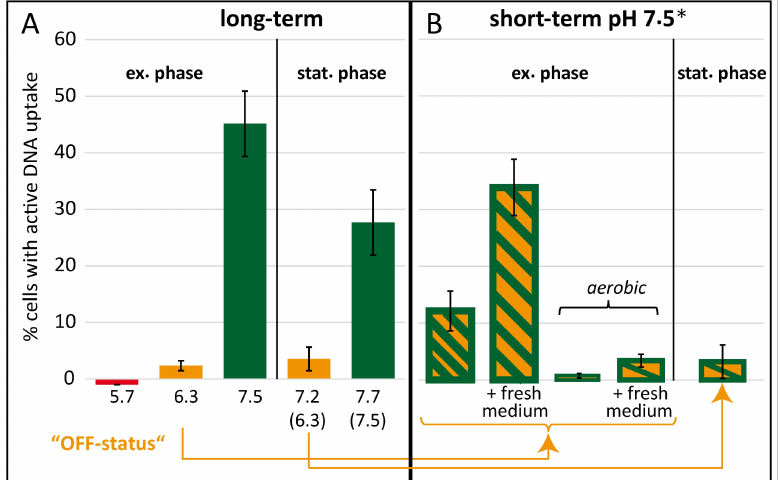
Figure 4. pH and atmosphere determine competence development in C. jejuni . Experimental setups for “long-term pH” ( A ) and “short-term pH shift” ( B ) of C. jejuni BfR-CA-14430 were as described in Figure 3. Final pH values ± 0.2 of cultures tested in the DNA uptake assay were as indicated, with initial pH-values ± 0.2 of original (exponential) cultures in brackets. The exponential culture with a final pH 6.3 and its corresponding stationary culture without pH adjustment (pH 7.2) were used as “OFF-status” cultures for short-term pH shifts. Ex. phase, exponential phase culture with OD 600nm of 0.1–0.5; stat. phase, stationary phase culture with OD 600nm of 0.8–1.5. Fresh medium, cultures were diluted 3 to 5-fold with Bolton broth; aerobic, atmosphere was changed to aerobic conditions for short-term challenge; *, final pH 7.9 instead of 7.5 due to additional release of CO 2 from the medium. DNA uptake occurred under aerobic conditions at pH 7.5 ± 0.1 except for culture pH 5.7, for which uptake was kept at the same pH value of 5.7 (see also Table 1). Experiments were performed at least three times. Error bars indicate standard